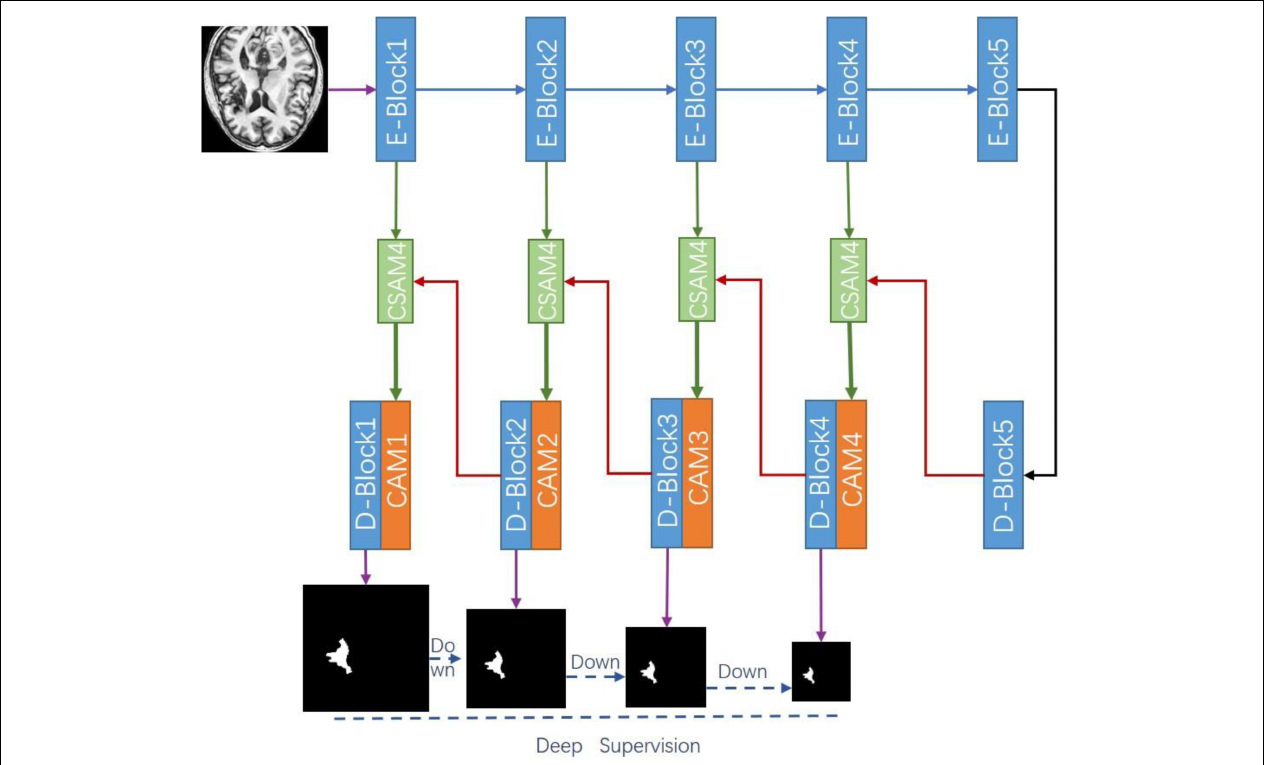
FIGURE 1 | Overview of our proposed cross-attention and deep supervision UNet